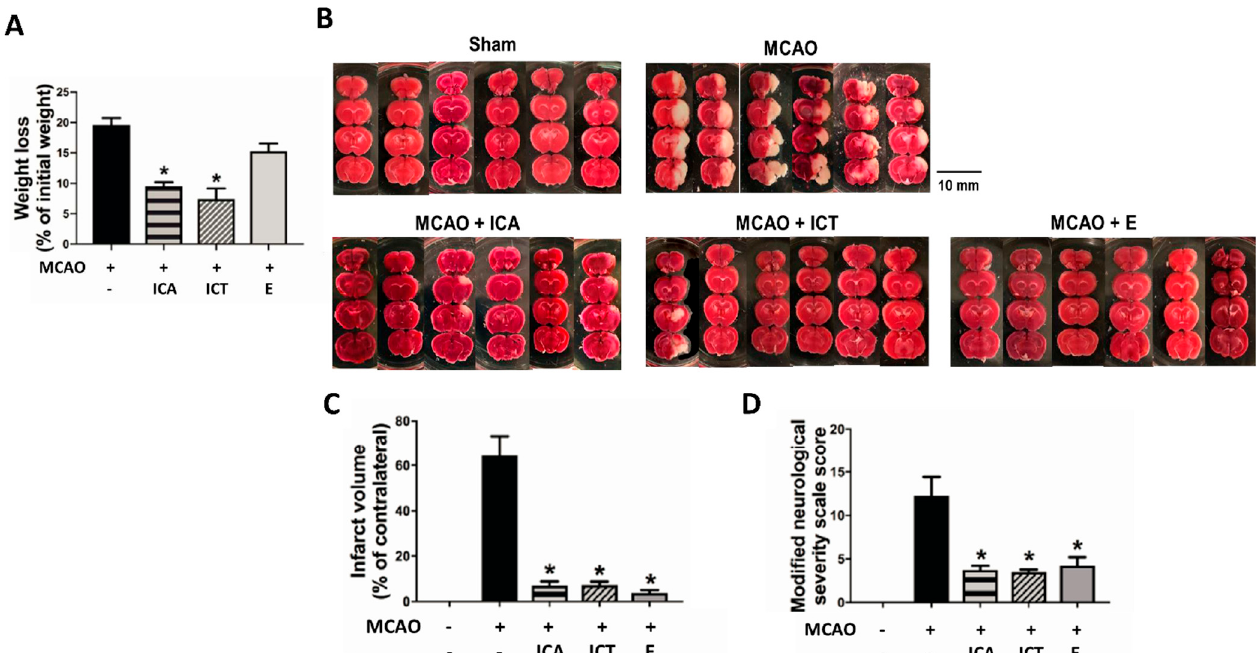
Figure 1. The preventive effects of both icariin (ICA) and icaritin (ICT) on body weight loss, neurological severity, and infarct volume in mice with acute cerebral ischemia–reperfusion. Mice were pretreated with ICA (60 mg/kg), ICT (60 mg/kg), and edaravone (E; 3 mg/kg, as a positive control) before MCAO followed by reperfusion. ( A ) The average body weight loss percentage of mice in each group was calculated. ( B ) Photographs of the mice cerebral infarct areas in each group were shown. ( C ) The quantification of infarct volume is shown. ( D ) The modified neurological severity score (mNSS) in each group was evaluated. Data are presented as mean ± SD ( n = 6). * p < 0.05 compared to the MCAO group.